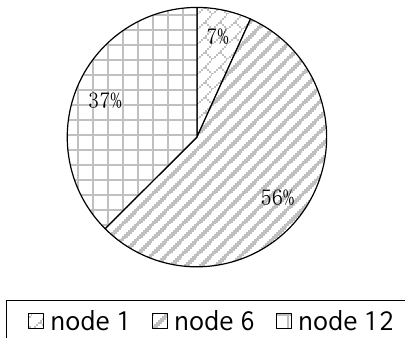
Figure 14. Percentages of the amounts of energy recharged at each charging station.